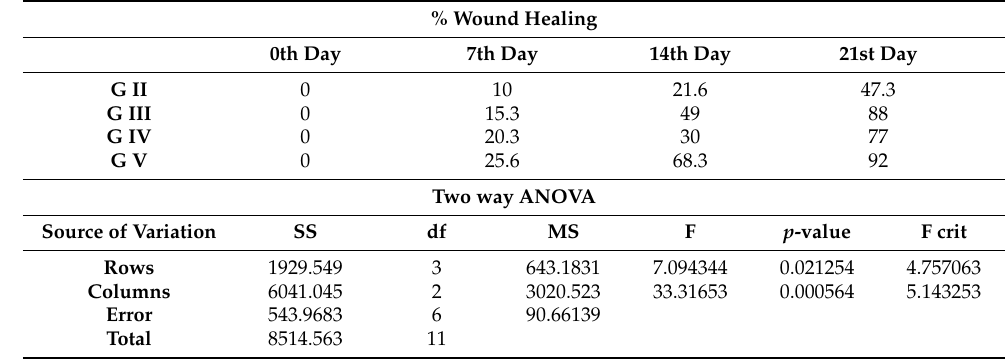
Figure 9. The effect of storage at 4 °C for one month on EE%, vesicle size and zeta potential of the optimized formula. Table 7. Percentage of wound healing activity and ANOVA